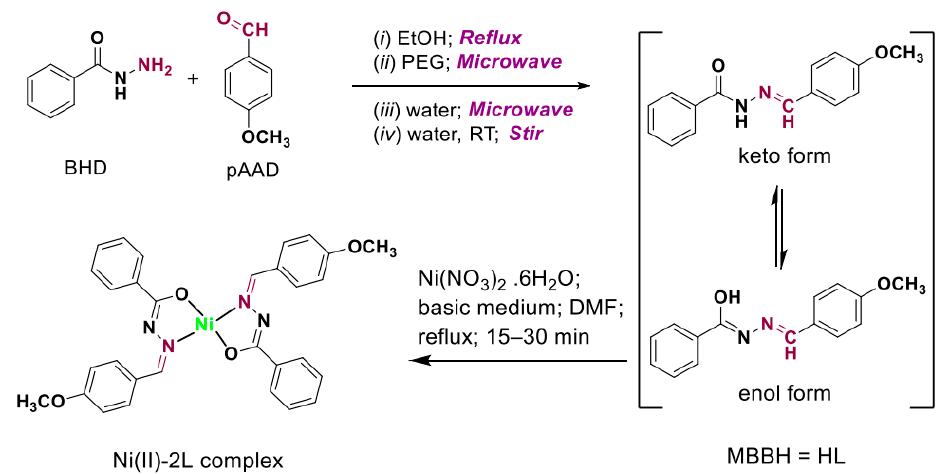
Figure 1. Schematic presentation of the methods used for the synthesis of anisole Schiff base (HL) and its nickel(II) complex (Ni(II)-2L).